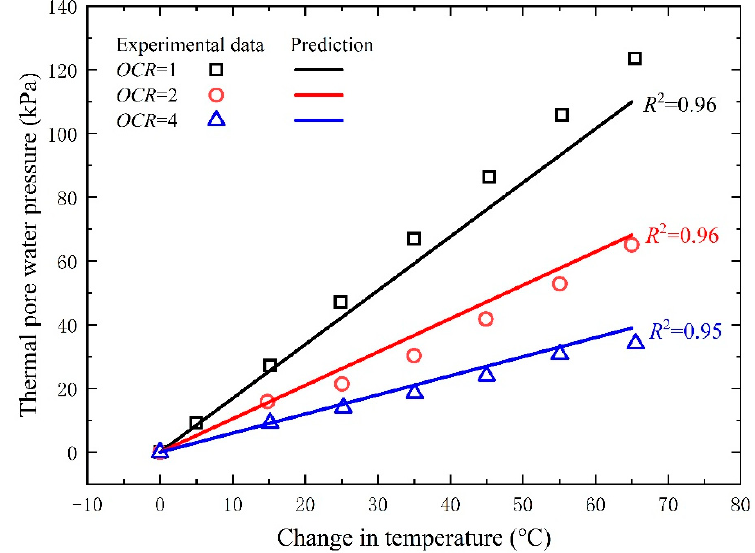
Figure 2. Comparison of predicted thermal pore water pressure against the results of Abuel-Naga et al. (2007).